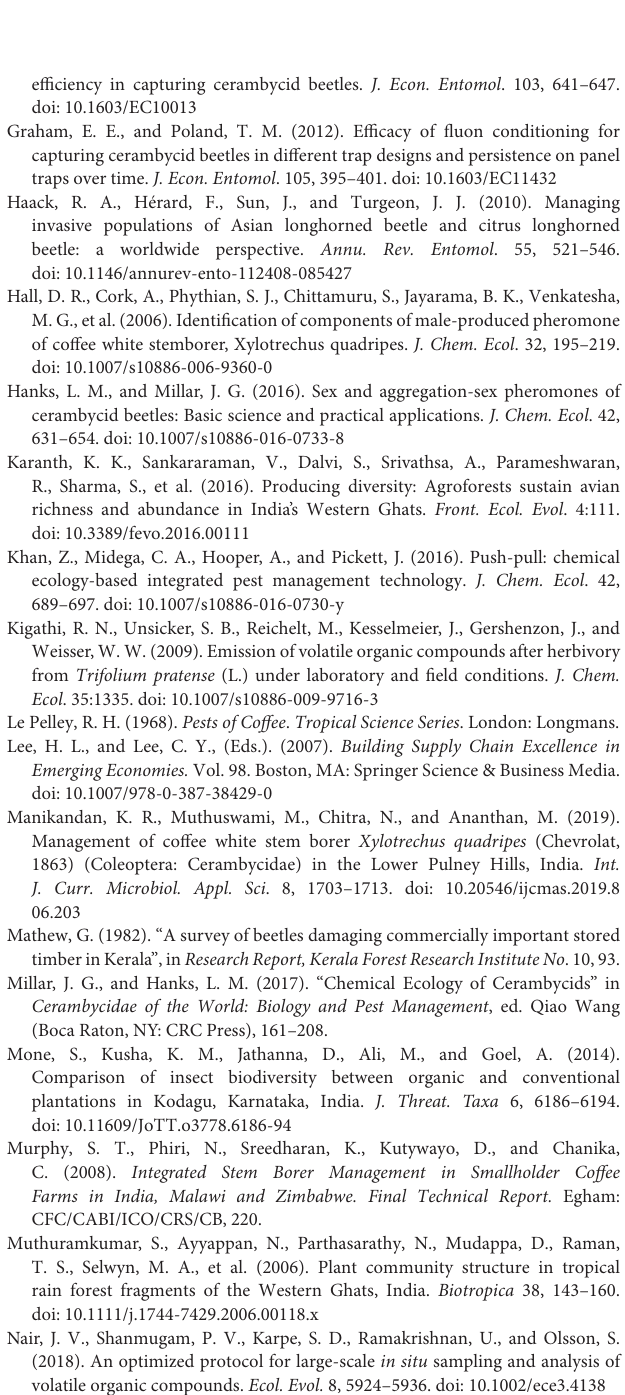
Supplementary Table 2 | Volatile release rate ratio of leaf blend (LB). Volatile release rate ratio of LB (10 − 3 v/v) at different hours of field exposure compared with the relative area % of coffee leaf volatiles (arabica, n = 4). Supplementary Table 3 | Volatile release rate ratio of wood blend 1 (WB1). Volatile release rate ratio of WB1 (10 − 2 v/v) at different hours of field exposure